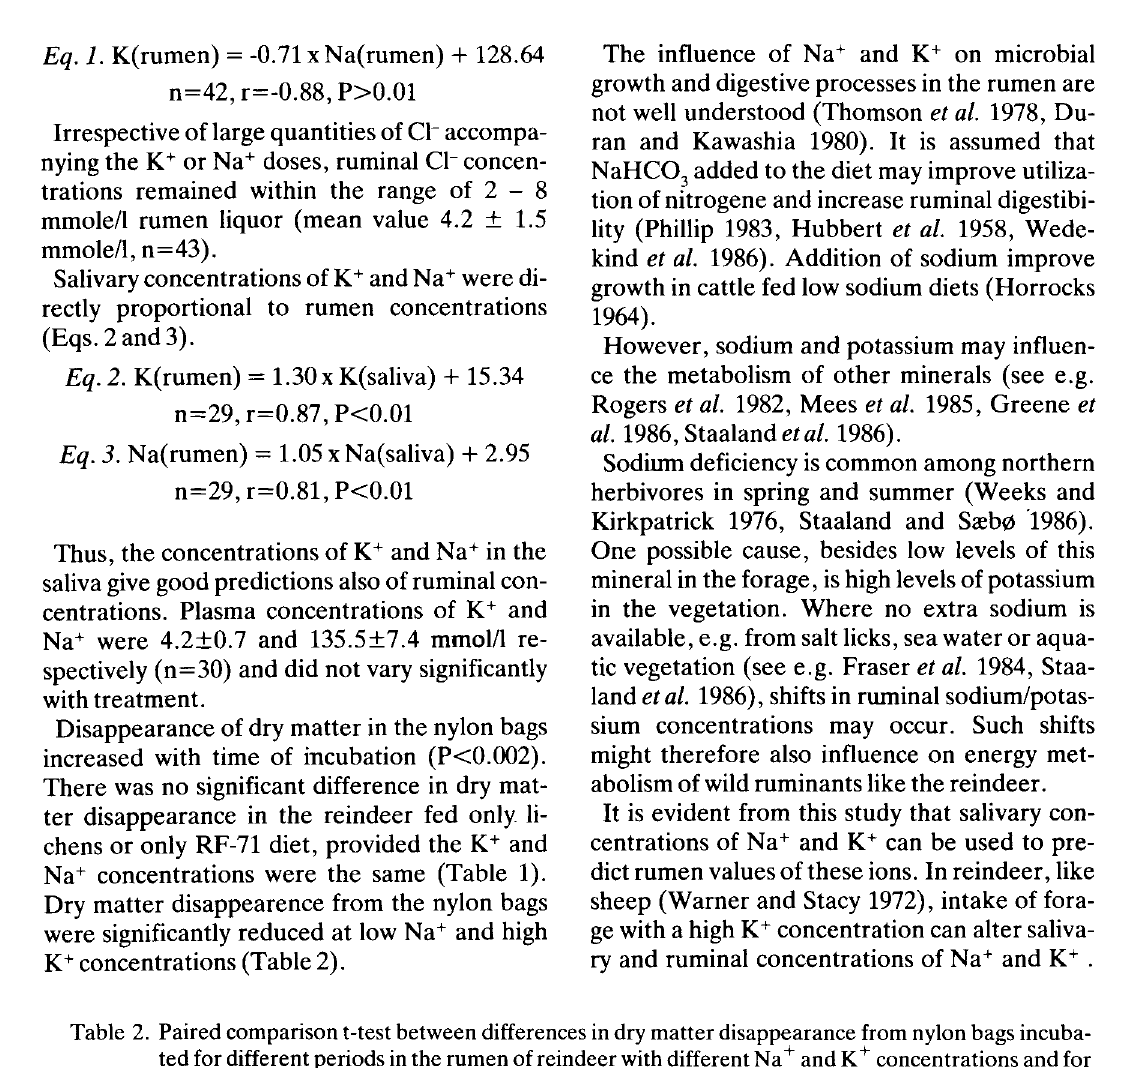
Table 2. Paired comparison t-test between differences in dry matter disappearance from nylon bags incuba ted for different periods in the rumen of reindeer with different Na + and K + concentrations and for animals fed pure lichen of RF71 diets (n=6). See table 1 for further explanations. Differences between mean